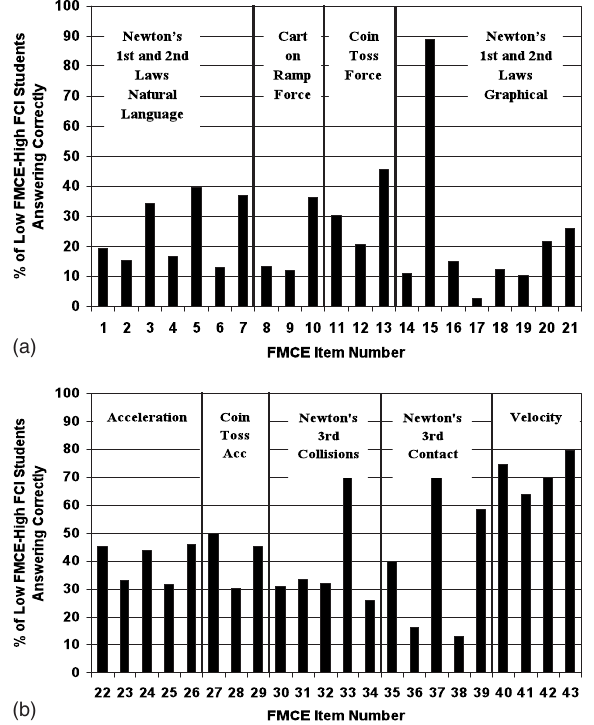
FIG. 5. (cid:3)(cid:1) a (cid:2) and (cid:1) b (cid:2)(cid:4) Results on individual FMCE items for students with 406 low on the FMCE (cid:1) (cid:2) 0.4 (cid:2) and high on the FCI (cid:1) (cid:4) 0.6 (cid:2) score pairs. Students are taken from both the pre- and postevaluations.